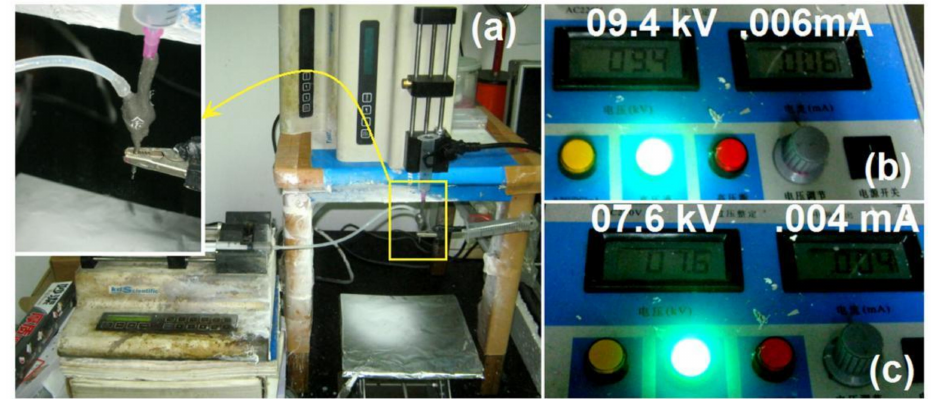
Figure 4. Comparison of the energy consumption of electrospinning processes using the traditional metal tube-based spinneret and the new concentric spinneret. ( a ) Digital photograph of the working process. Top-left inset: Connection of the small naked metal surface for electrostatic energy transfer. ( b ) Applied voltage and current of the traditional process. ( c ) Applied voltage and current of the new